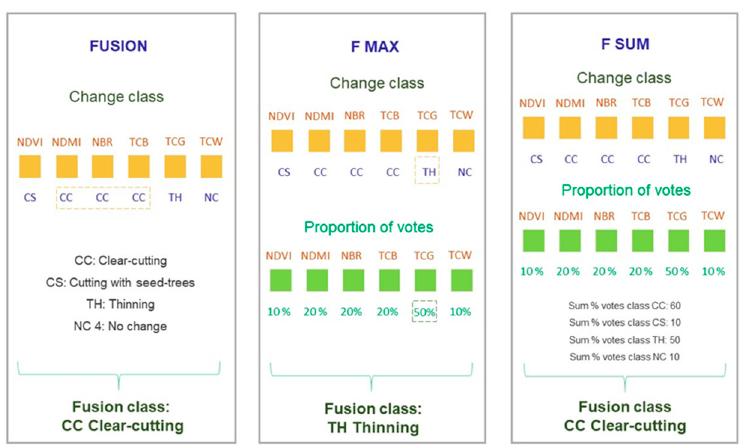
Figure 5. Example of different fusion options conducted for a specific pixel classified with six RF models, each calibrated with different outputs from the BFAST analysis. The change classes are: (1) clear-cutting (CC), (2) cutting with seed-trees (CS), (3) thinning operations (TH) and (4) no change (NC).